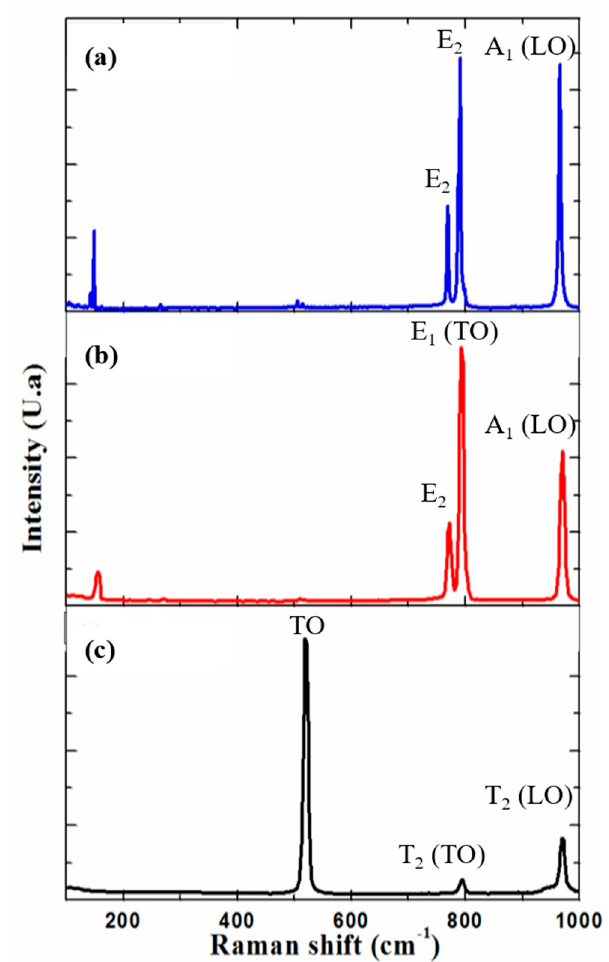
Figure 3. Raman signature spectra for the SiC polytypes: ( a )—6H (0001)-SiC, ( b )—4H-SiC (000-1), ( c )—3C-SiC (100) / Si (100). The main Raman modes are indicated. The strong peak at 500 cm − 1 in ( a ) corresponds to the TO ( Γ ) vibrations in the Silicon wafer Si (100).